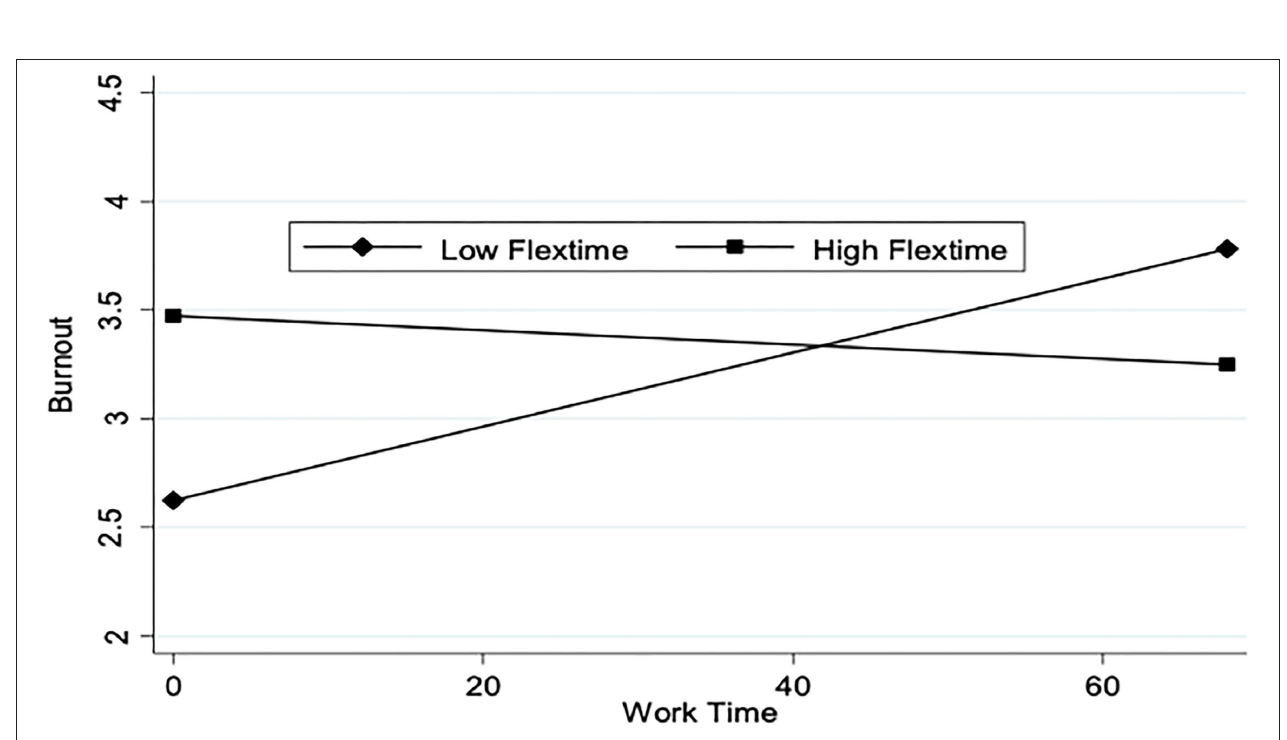
FIGURE 3 | Work time and predicted burnout by